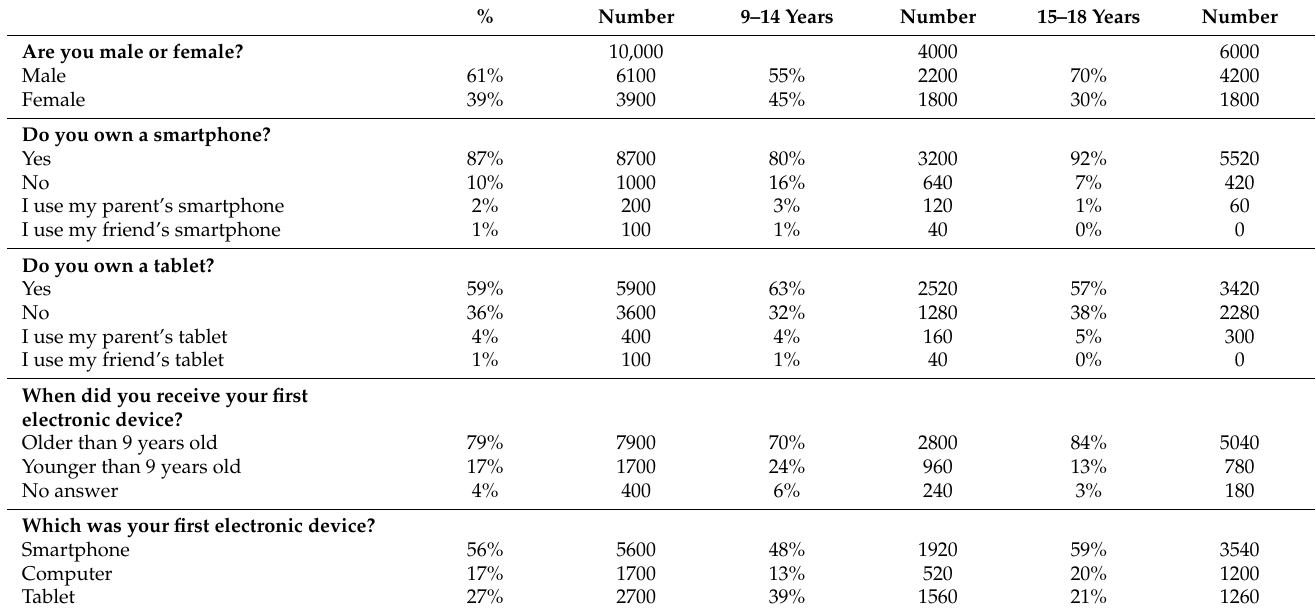
Table 1. Questionnaire about media device (MD) usage and perception among children and